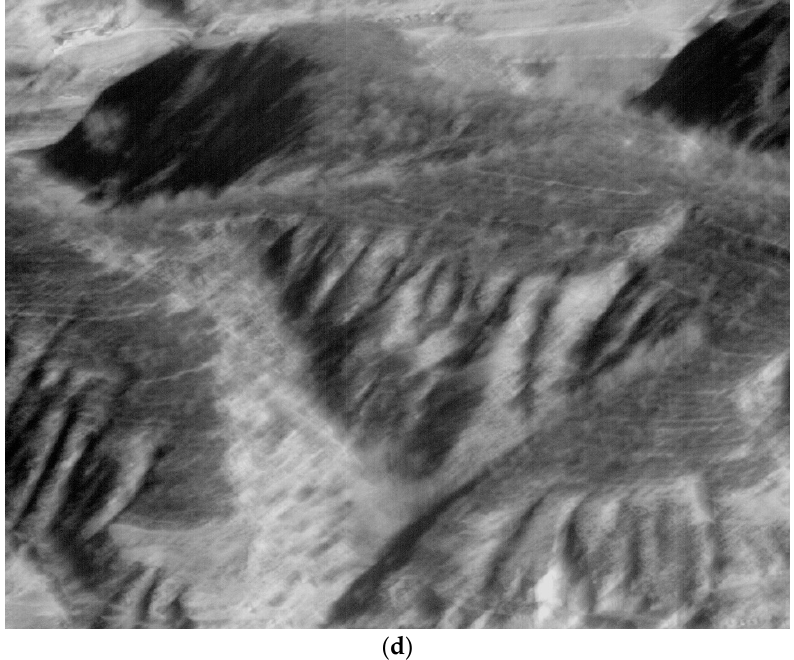
Figure 19. Images obtained from flight tests; ( a ) Infrared image with right IMC; ( b )Visible light image with right IMC; ( c ) Infrared image with wrong IMC; ( d )Visible light image with wrong IMC.